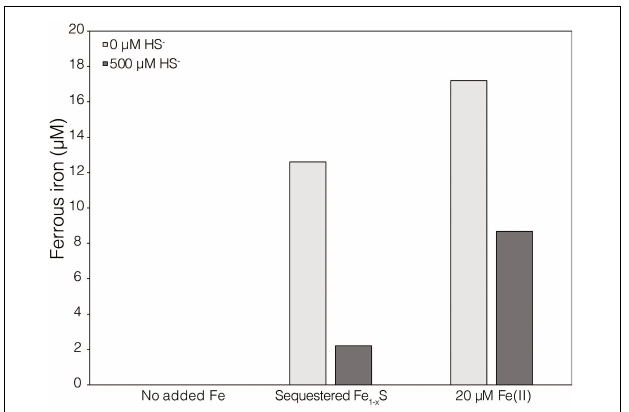
experiment reactors following 7 days of incubation at 38 ◦ C. One hundred sixty-five milliliters serum bottles containing base salts medium were provided with no Fe (No added Fe), 0.1 g of specimen pyrrhotite sequestered in 50 kDa dialysis tubing (Sequestered Fe 1 − x S), or 20 µ M FeCl 2 . Reactors were either provided with no sulfur source (0 µ M HS - ) or 500 µ M Na 2 S (500 µ M HS -